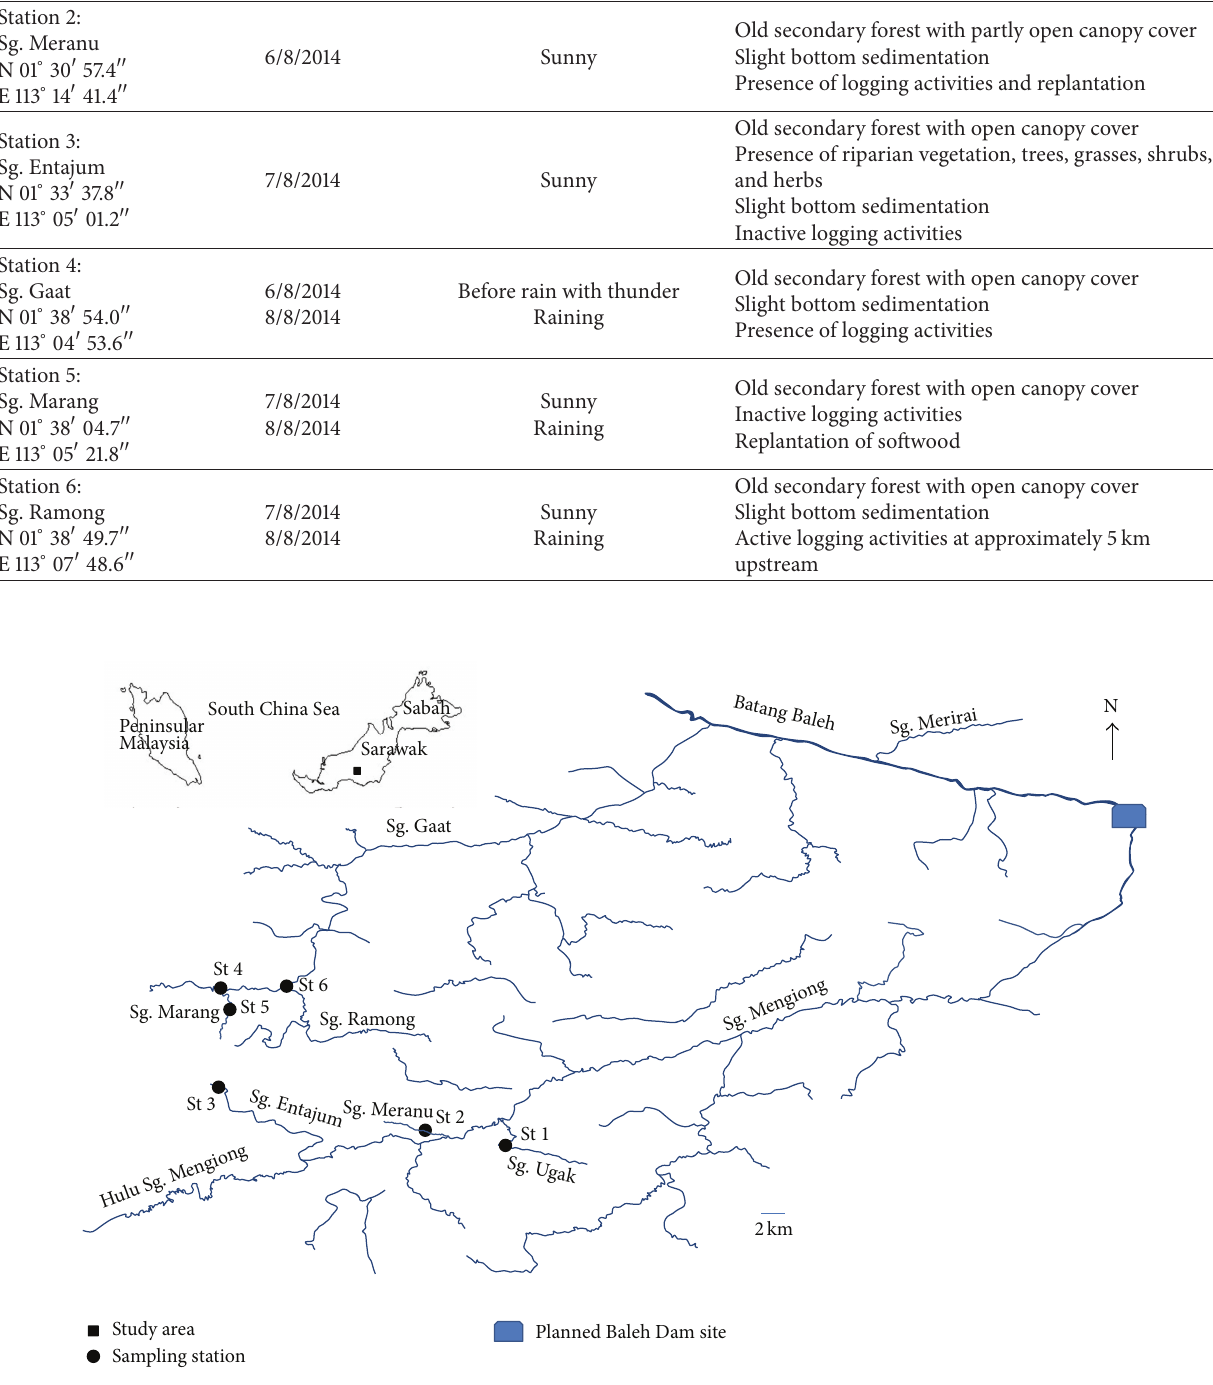
Figure 1: The study area in Sarawak state and location of the sampling stations in the present